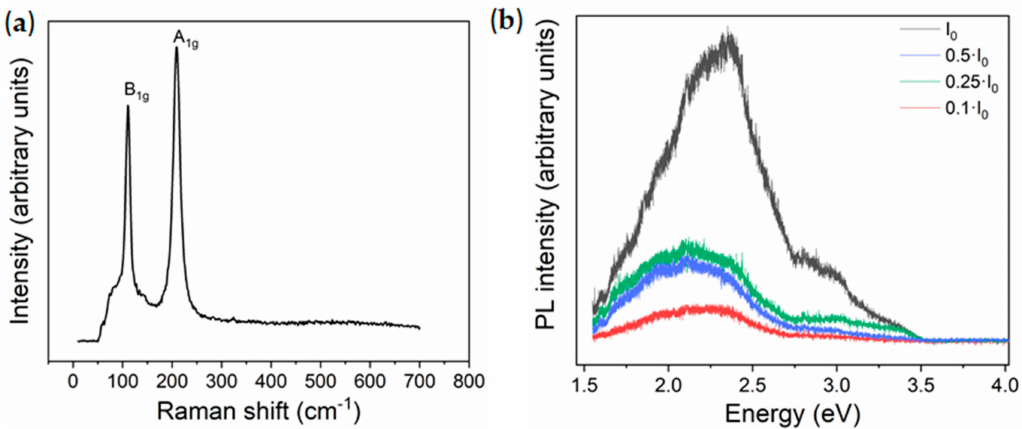
Figure 2. ( a ) Raman spectrum acquired with the He-Ne (633 nm) laser; ( b ) photoluminescence (PL) spectra acquired with the UV laser (325 nm) and variable laser intensity from SnO